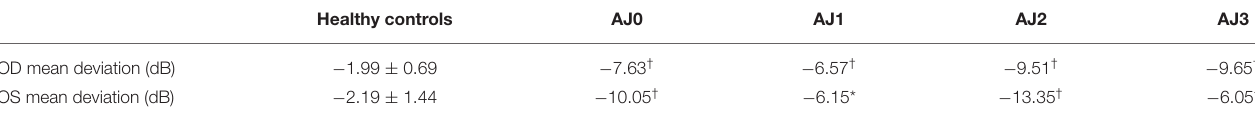
TABLE 2 | Mean deviation in AJ compared with healthy controls.